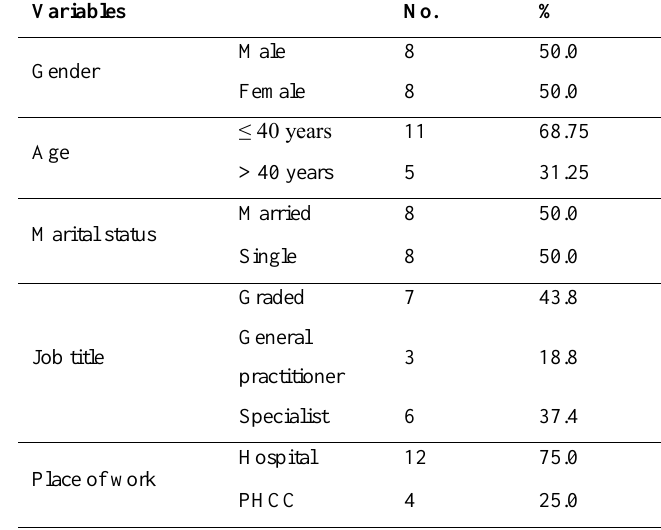
Table 5: Demography of participants in qualitative